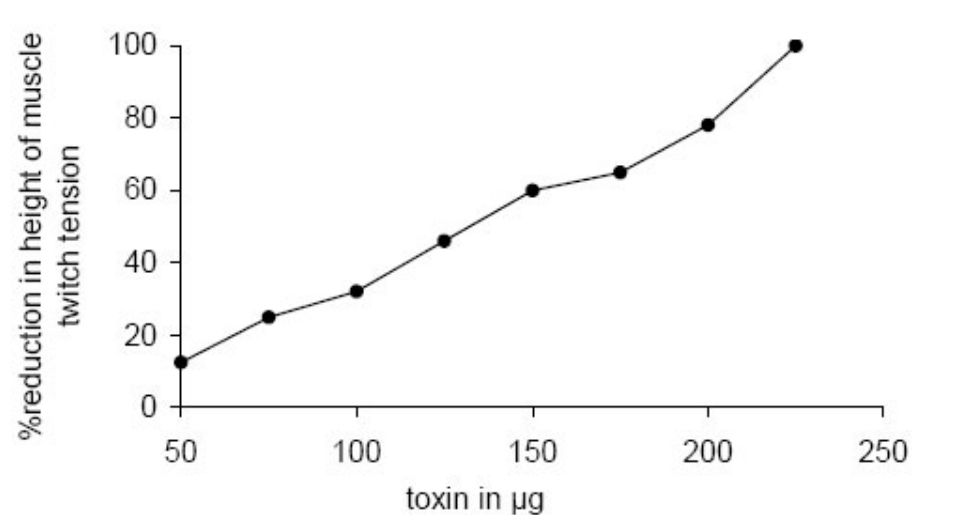
Figure 5: Percentage of reduction in the height of muscle twitch tension after treatment with purified toxin. A concentration of 225mg purified neurotoxin produced 100% inhibition of muscle twitch response within 3